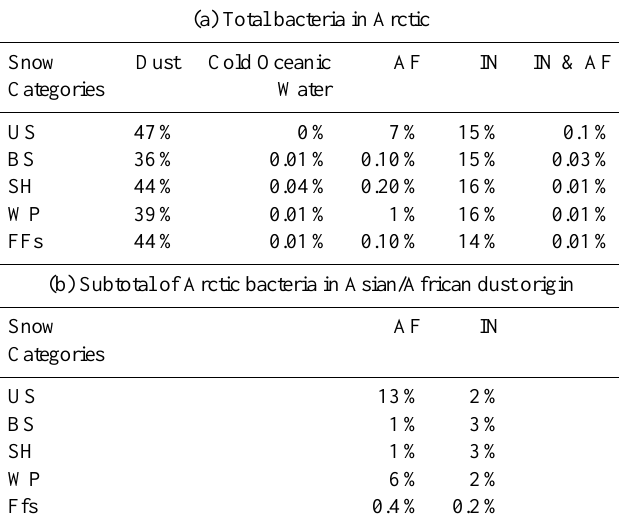
Table 1. Relative abundance of origin and physical properties of analyzed NGS bacteria. Bacteria in Arctic samples: blowing snow (BS), surface hoar snow (SH), windpack snow (WP), frost flowers (FFs); and urban snow (US) were analyzed for their origin, and ice nu- cleation/melting properties as detected by Roche 454 GS-FLX Titanium; (a) total bacteria in Arctic samples: (i) previously observed in Asian/African (dust); (ii) cold oceanic water, (iii) with antifreeze (AF), (iv) ice nucleation (IN), and (v) IN and AF property; (b) in subtotal of total Arctic bacterial pool originated from Asian/African dust: (i) with AF, or (ii) IN property. (a) Total bacteria in Arctic Snow